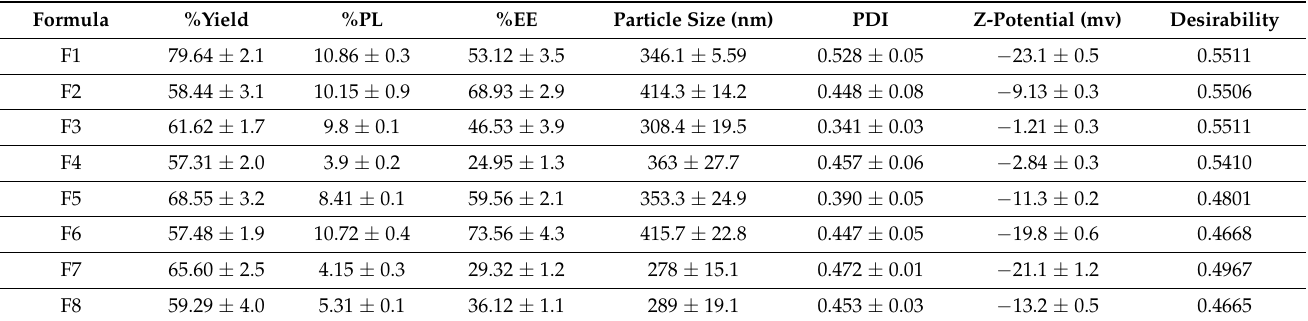
Table 3. Physical characterization of CS-LC nanoparticles and desirability values showing the optimum formula.